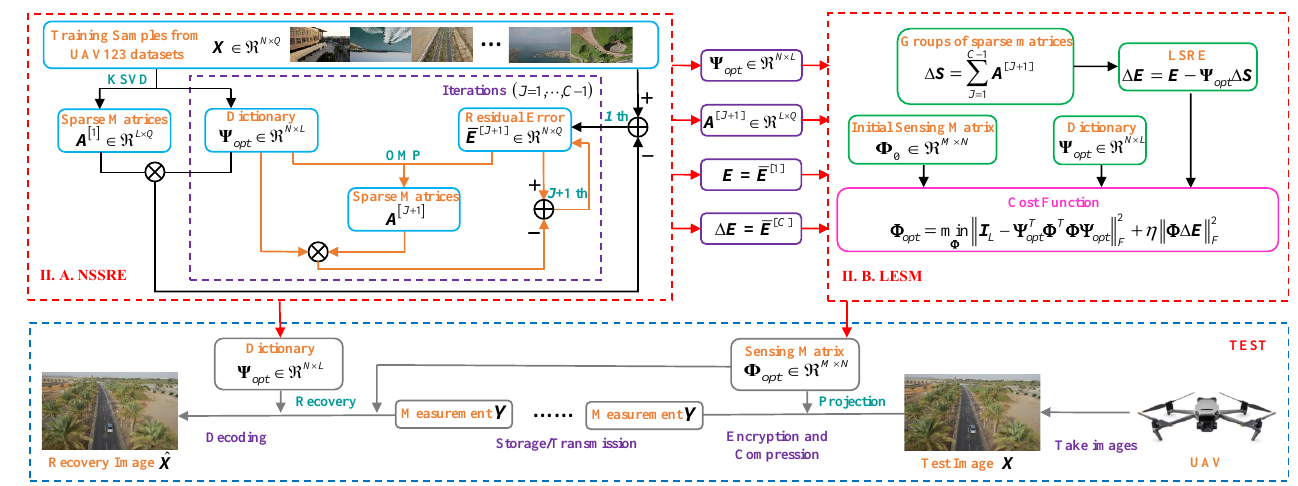
Figure 1. The CS framework of the proposed sensing matrix design (the red line) and the procedure for the UAV images compression and recovery (the blue